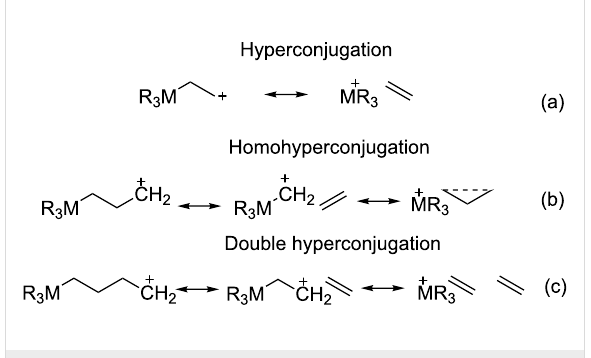
Figure 2: Schematic representation of stereoelectronic effects (a) hyperconjugation, (b) homohyperconjugation, (c) double hyperconjuga- tion.